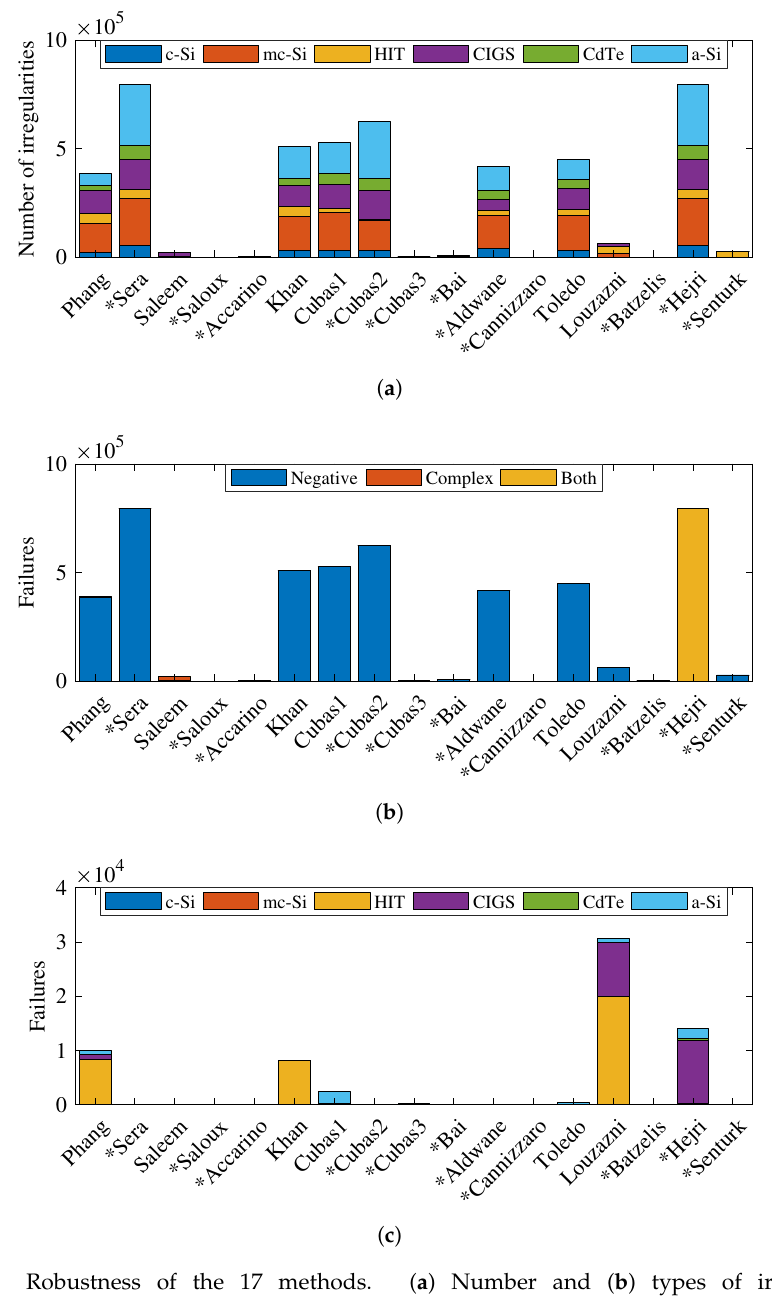
Figure 5. Robustness of the 17 methods. ( a ) Number and ( b ) types of irregularities. ( c ) Execution